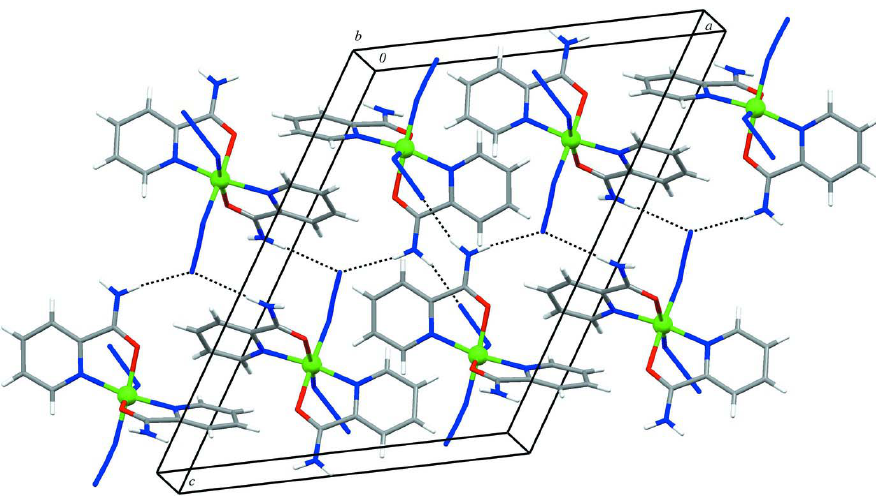
Figure 2 Crystal packing of (I) showing the hydrogen bonds as dashed lines. cis -Bis(azido- κ N )bis(pyridine-2-carboxamide- κ 2 N 1 , O